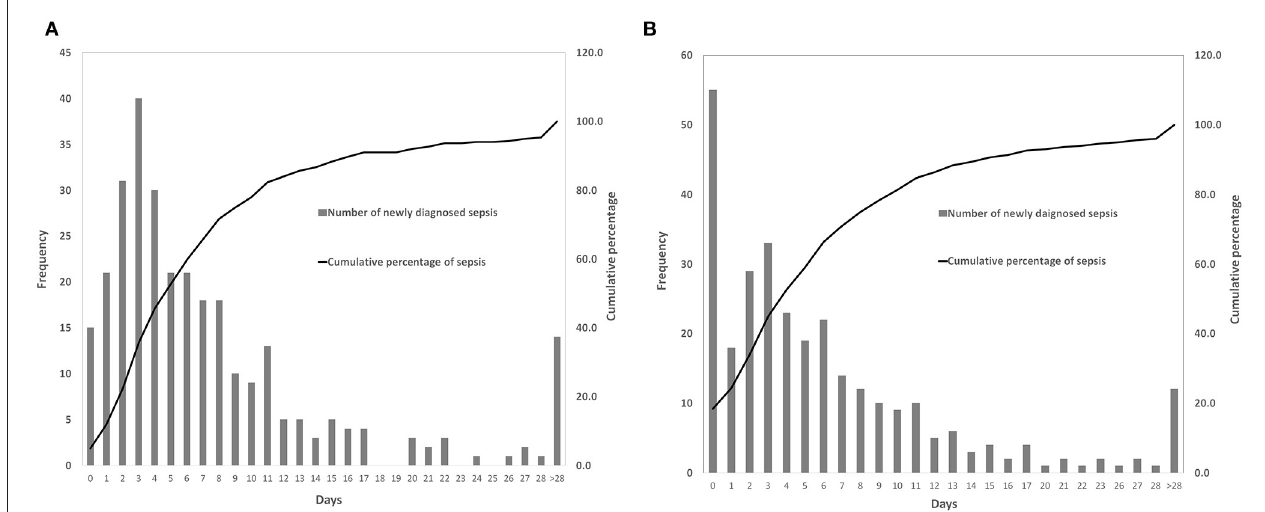
FIGURE 2 | Time of the patients diagnosed with sepsis. (A) The occurrence time of sepsis after craniotomy. (B) The occurrence time of sepsis after intensive care unit (ICU) admission.